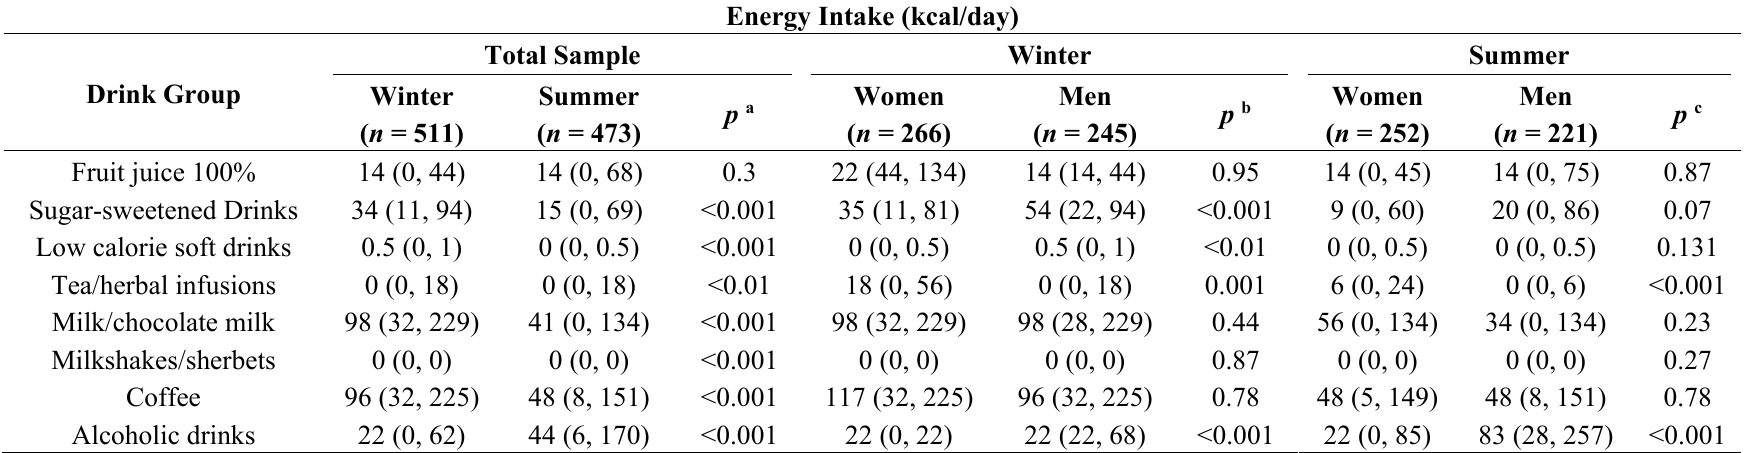
Milkshakes/sherbets 0 (0, 0) 0 (0, 0) <0.001